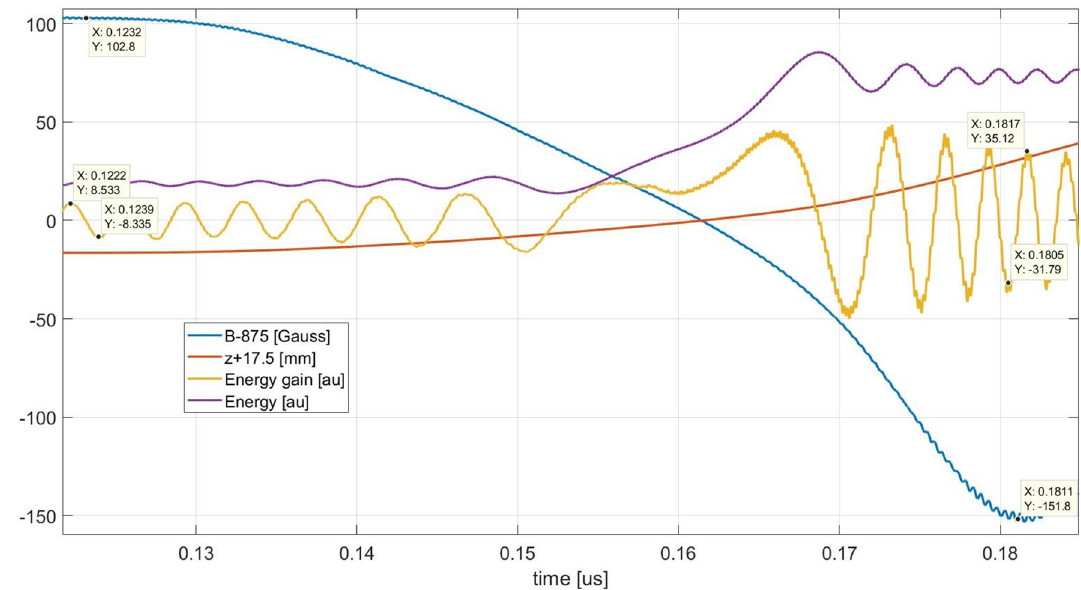
Figure 15. Beats analysis.